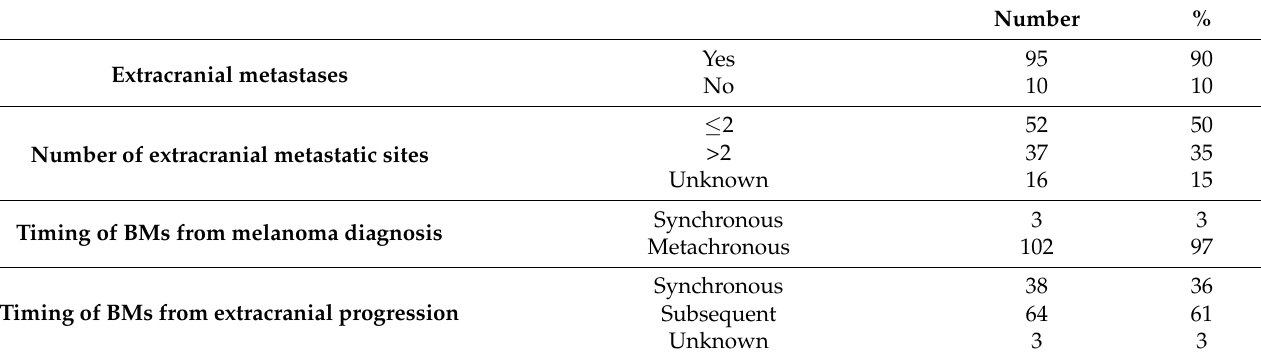
Table 2. Metastatic disease